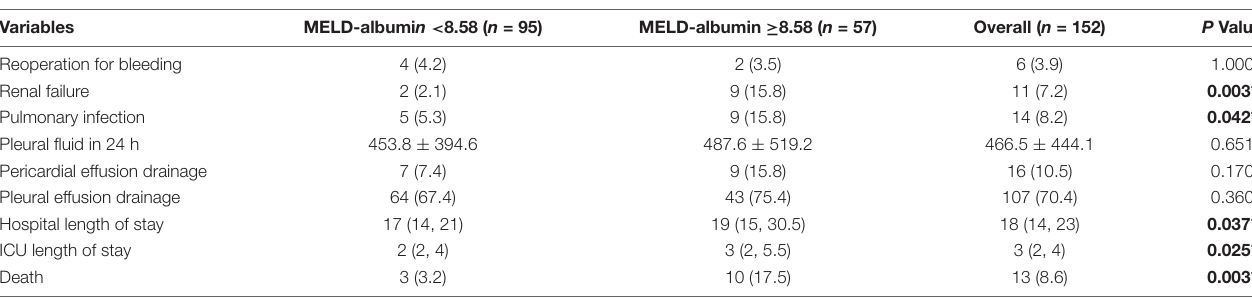
FIGURE 3 | The correlation between MELD, MELD-XI or MELD-albumin, and continuous variables in patients following ITVR by mantle test. MELD, model for end-stage liver disease; MELD-albumin, model for end-stage liver disease with albumin replacing international normalized ratio; MELD-XI, model for end-stage liver disease excluding international normalized ratio; BMI, body mass index; ALT, alanine transaminase; AST, aspartate transaminase. TABLE 4 | Postoperative outcomes for different MELD-albumin